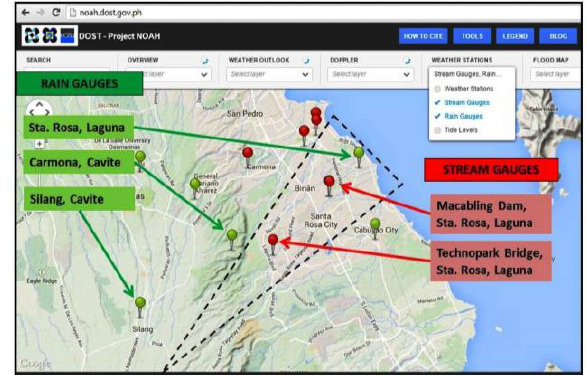
Figure 2. Available rain gauges and stream gauges